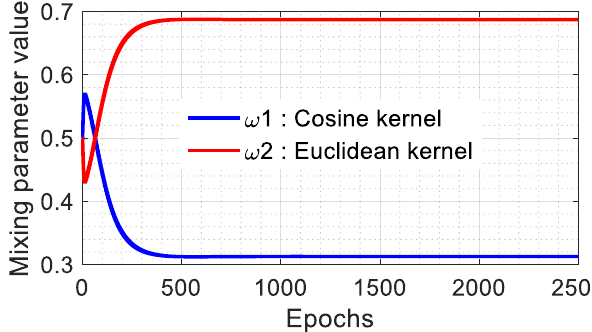
Figure 6. Mixing parameters for dynamic fusion of kernels.